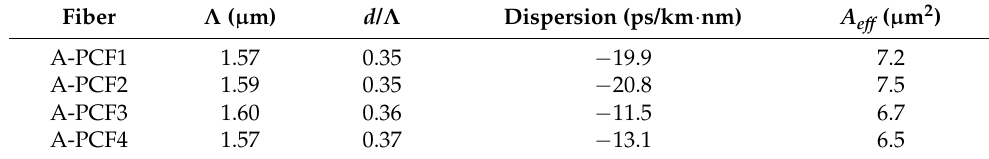
Figure 5. ( a ) SEM images of air-filled PCFs cross-section. ( b ) Chromatic dispersion of air-filled PCFs. Dashed vertical black line indicates the experimental pump wavelength. Table 1. Structural parameters, dispersion and effective mode area at 1064 nm of air-filled